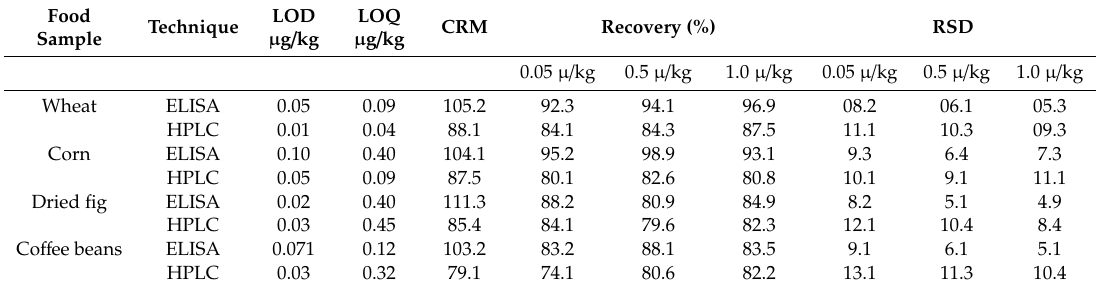
Table 2. Statistical parameters for the determination of total aflatoxins in food samples by using HPLC and ELISA